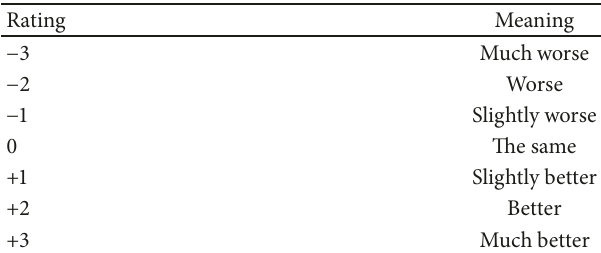
Figure 16: Timing diagram for stimulus presentation (variant 2). Table 7: SCACJ quality